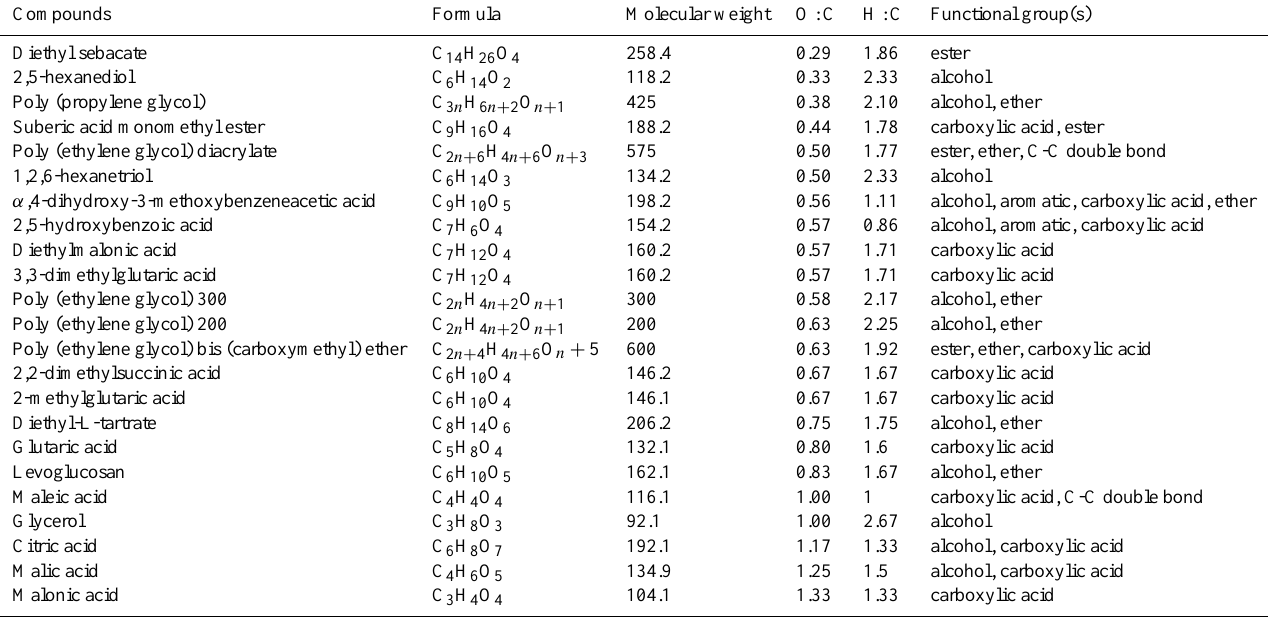
Table 1. Summary of different organics used in the liquid–liquid phase separation experiments.